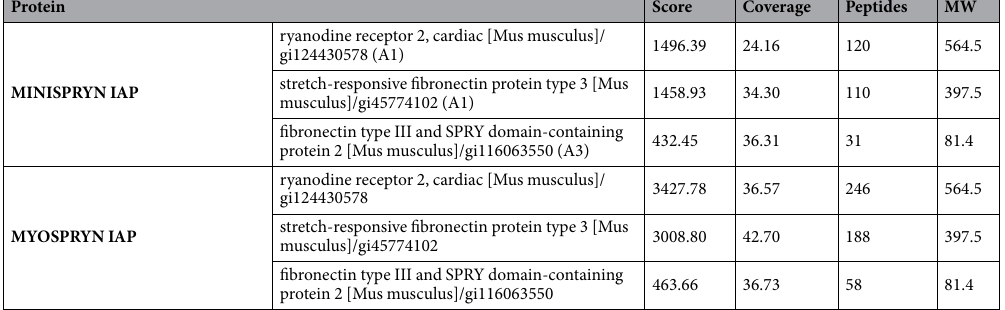
Table 1. Mass spectrometry statistics for minispryn and myospryn immunoaffinity purification from mouse heart. Proteins identified by mass spectrometry from minispryn (Fig. 3a) and myospryn (Supplementary Fig. S4) immunoaffinity purification from cardiac muscle. For clarity, in this study we have only focussed on the three most significant matches from each experiment. Note that stretch-responsive fibronectin protein type 3 [ Mus musculus ]/gi45774102 is the alternative name for Cmya5 /myospryn and fibronectin type III and SPRY domain-containing protein 2 [ Mus musculus ]/gi116063550 is Fsd2